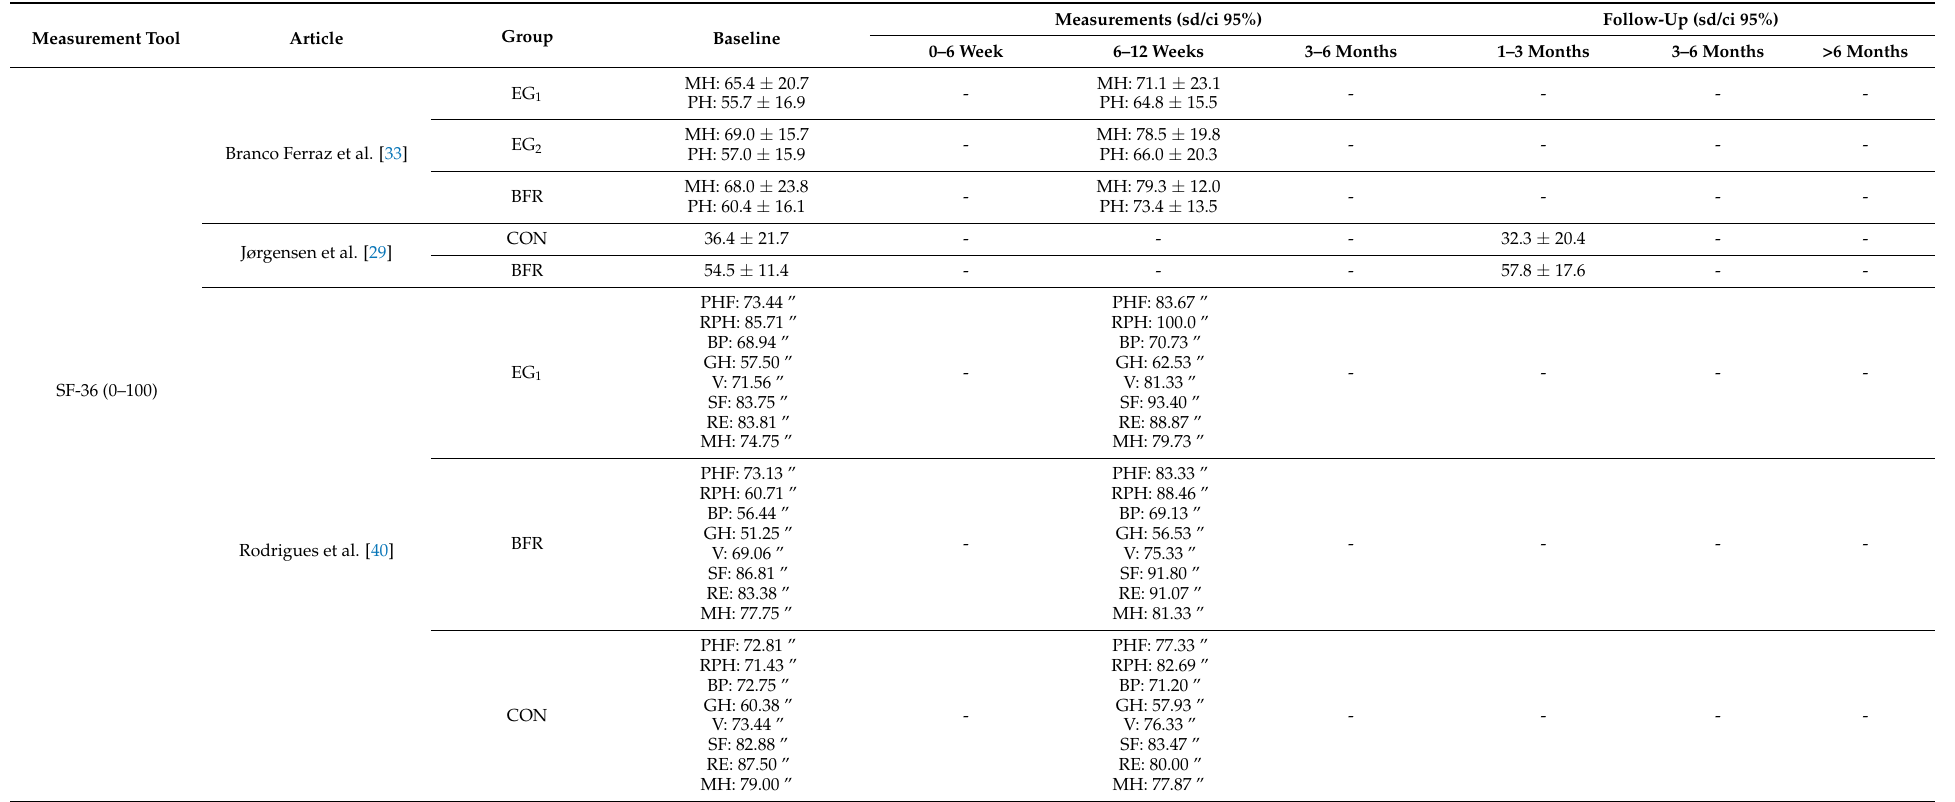
Table 6. Quality of life analyzed in the short-, medium-, and long-term, both during the intervention period and in a follow-up that may be longer than 6 months after the end of the